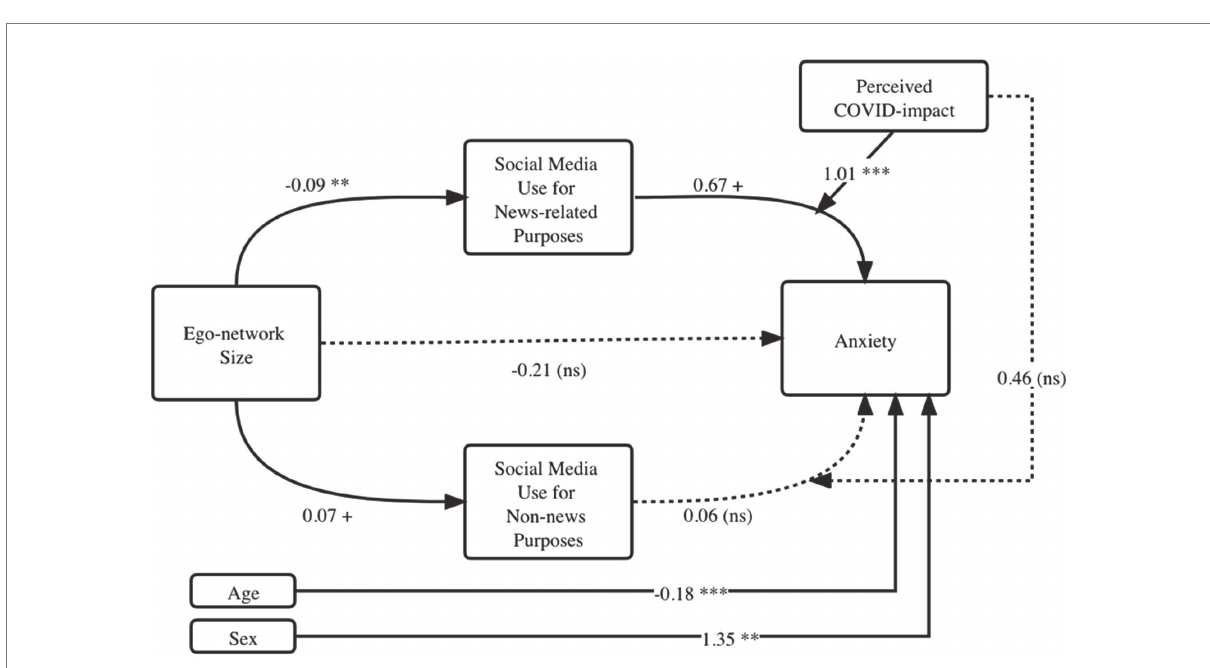
FIGURE 4 Moderated mediation analysis results (Study 2). Dotted lines represent non-significant paths. + p < 0.10, ** p < 0.05, *** p < 0.01. Coefficients are